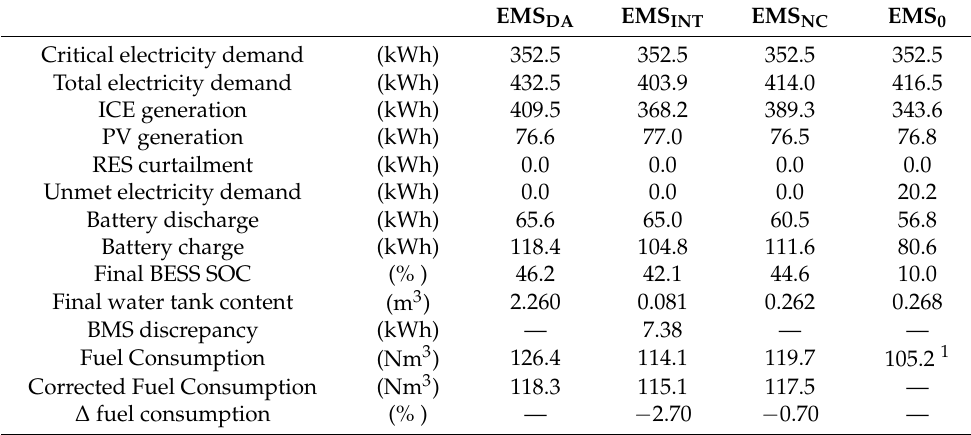
Figure 11. Microgrid dispatch comparison—day 2. (EMS INT reflects the actual microgrid operation while the others are simulation results). Table 4. Energy summary—day 2 (the microgrid was operated with EMS INT , while the others are simulations